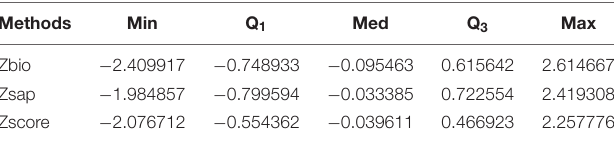
TABLE 4 | Descriptive statistics of the three evaluation